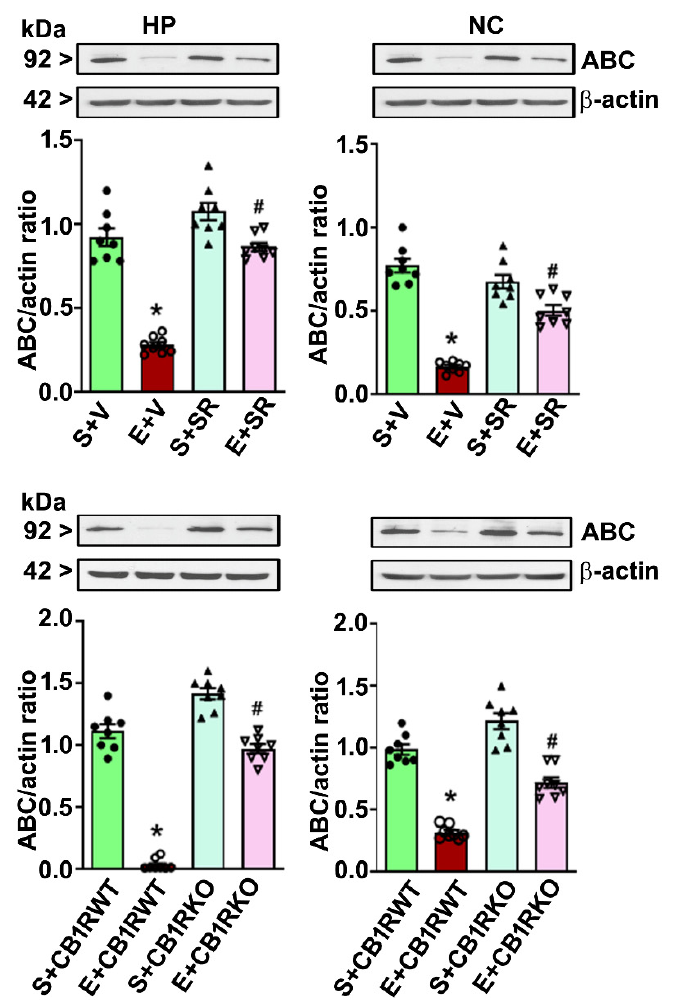
Figure 5. Pharmacological inhibition or genetic deletion of CB1Rs mitigates the loss of nuclear ABC caused by high-dose ethanol exposure in P7 mice. The ABC protein levels were evaluated by Western blot analysis in the nuclear fractions of the HP and NC samples from the different treatment groups (S + V, E + V, S + SR and E + SR; S + CB1RWT, E + CB1RWT, S + CB1RKO and E + CB1RKO). Error bars, SEM (* p < 0.05 vs. the S + V or CB1RWT + S group; # p < 0.05 vs. the E + V or CB1RWT + E group, n = 8 pups/group).